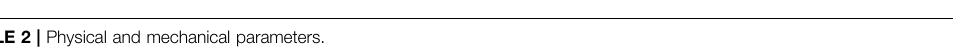
TABLE 2 | Physical and mechanical parameters.